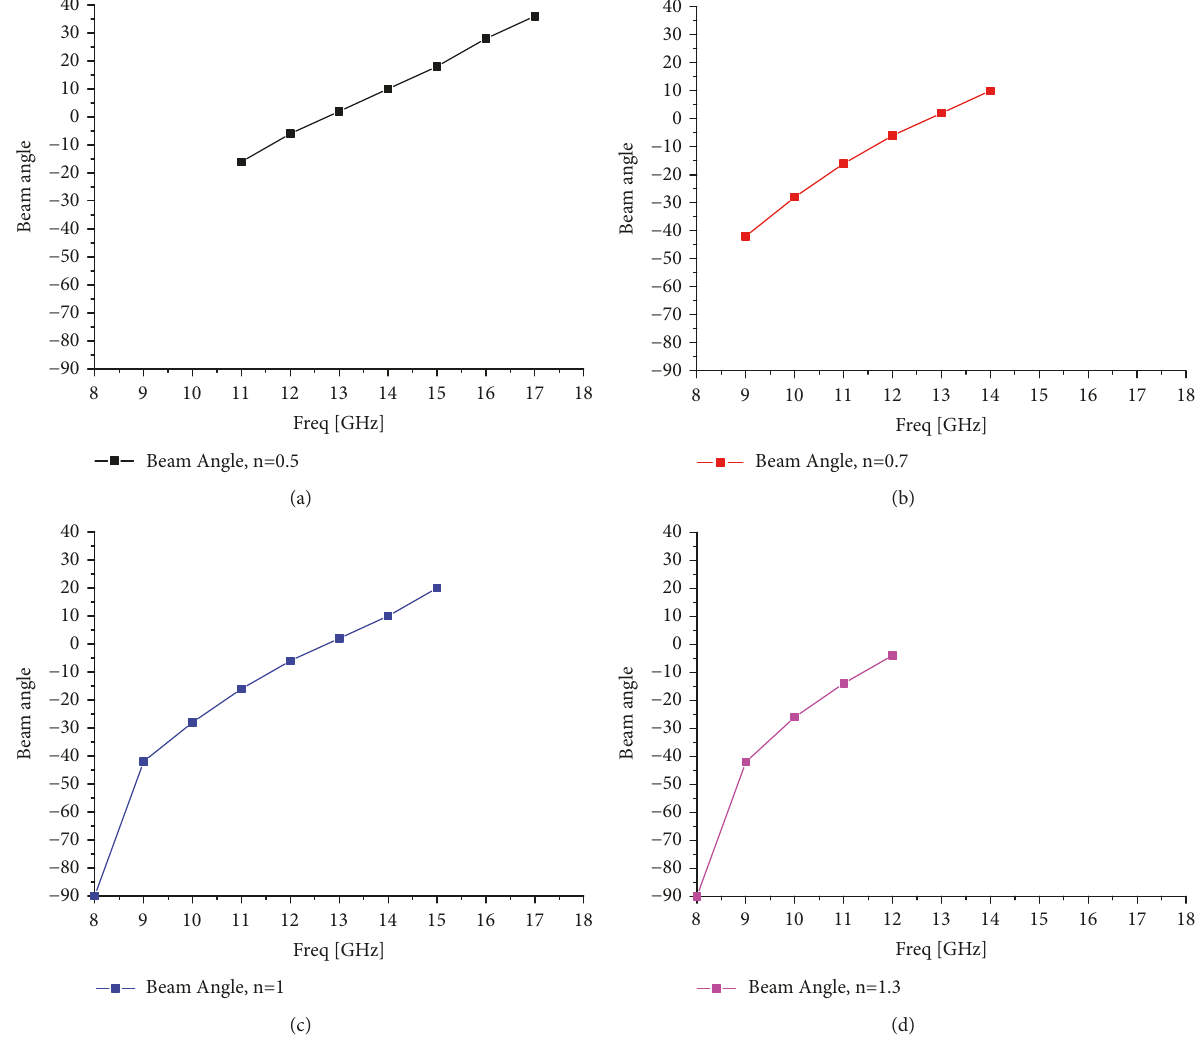
Figure 12: Influence of CSRR size on beam deflection angle. (a) n=0.5. (b) n=0.7. (c) n=1. (d) n=1.3.